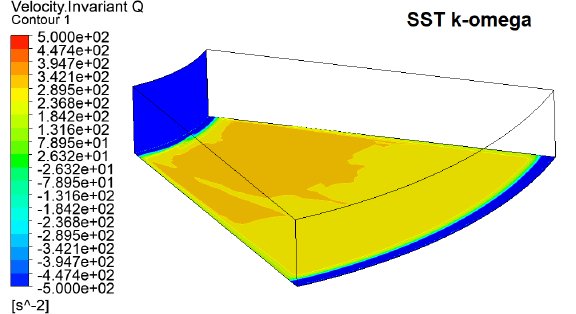
Fig. 9. Q-criterion: RSM